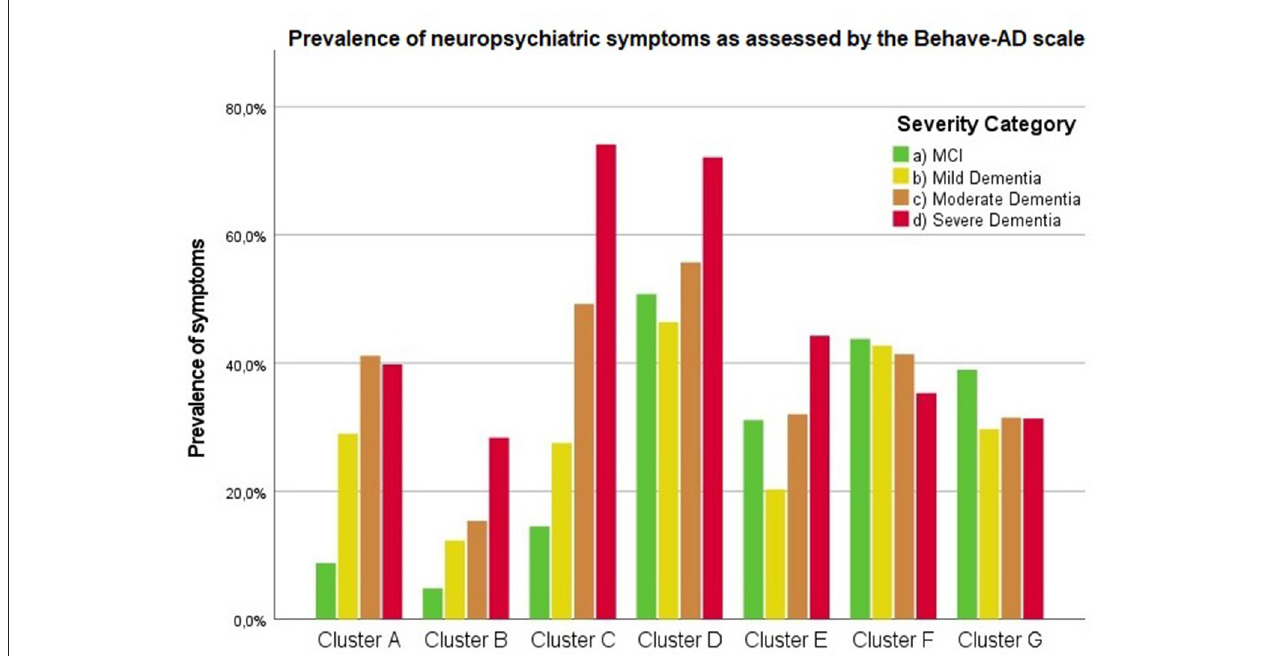
FIGURE 1 | Presence of any neuropsychiatric symptoms as assessed by the Behave-AD scale according to severity of cognitive decline. Cluster A: paranoid and delusional ideation, Cluster B: hallucinations, Cluster C: activity disturbances, Cluster D: aggressiveness, Cluster E: diurnal rhythm disturbances, Cluster F: affective disturbances, Cluster G: anxieties and